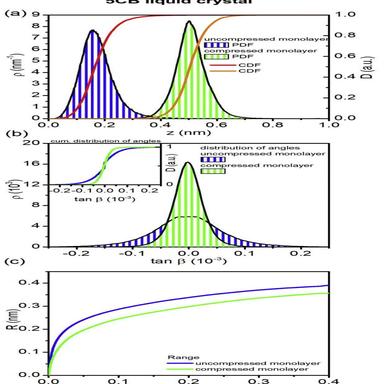
The statistical analysis of 5CB liquid crystal (left column) and 5CB/CNC nanocomposite (right column) surface at the air-water interphase; the probability distribution of height (a), the probability distribution of angles of LC molecules (b), and calculated range (c).